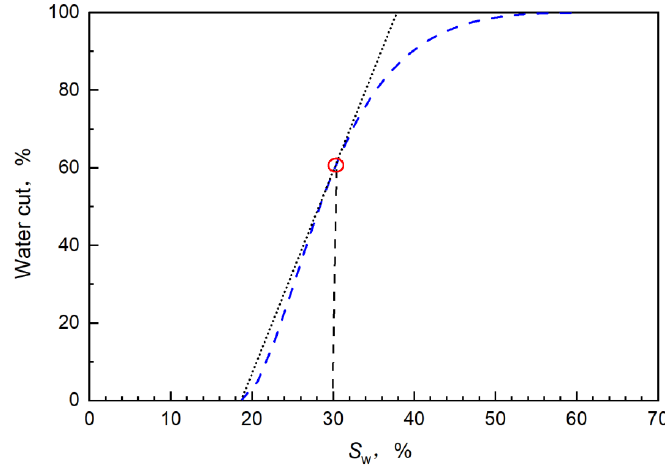
Figure 6. The curve of the water cut changing with water saturation.